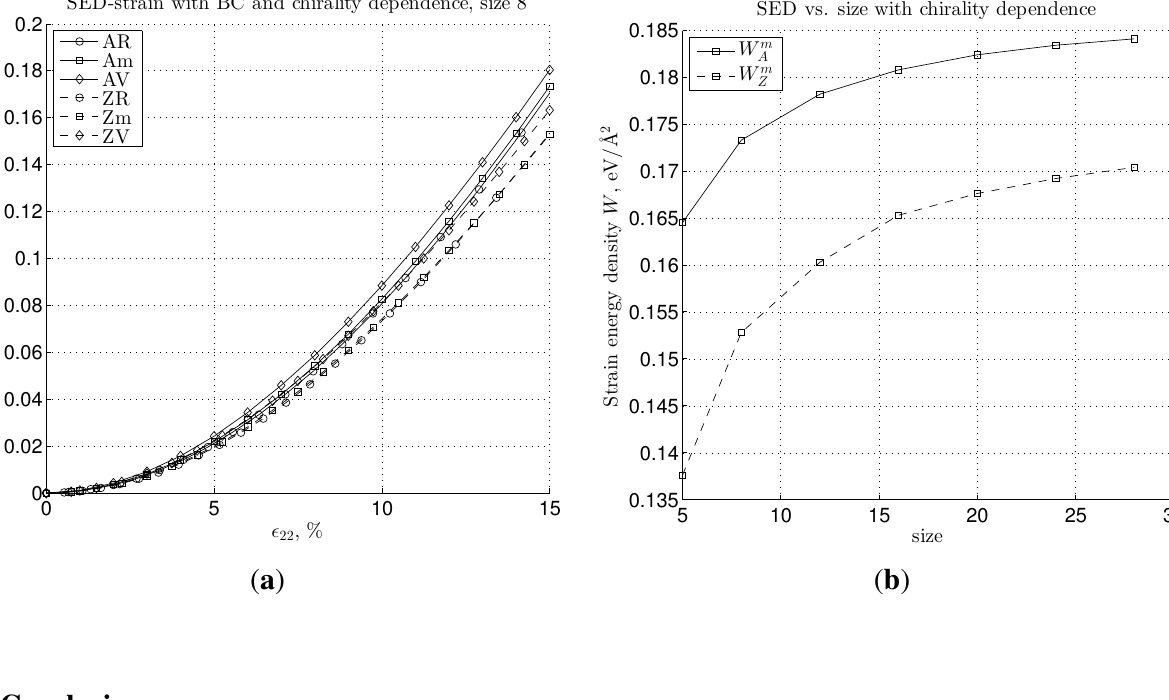
Figure 10. The strain energy density plot shows the dependence on the chirality (armchair and zigzag) and BC types, “R”, “m” and “V”, in ( a ) and the influence of size and chirality to the strain energy density in ( b ) (for the “m” BC case and strain (cid:15)